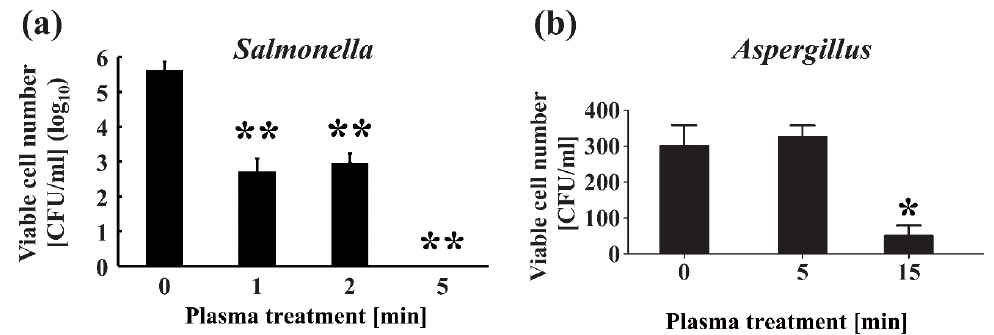
Figure 2. Direct plasma treatment inactivates bacteria and fungi. ( a ) A sample of Salmonella was treated with plasma using the BLP-TES (bi-polar and low-pressure plasma-triple effects sterilization) device, which generates nitrogen gas plasma using a fast high-voltage pulse by a static induction (SI) thyristor power supply, for the indicated time. Colony-forming units (CFU) per ml of culture reduced with the plasma treatment in a time-dependent manner. ( b ) Viable cell numbers of Aspergillus reduced after plasma treatment using the BLP-TES device. Differences where * p < 0.05 and ** p < 0.01 versus control (0 min) were considered significant. Modified from Maeda et al. 2015 [55] and Sakudo et al. 2017 [57] with permission from Elsevier.